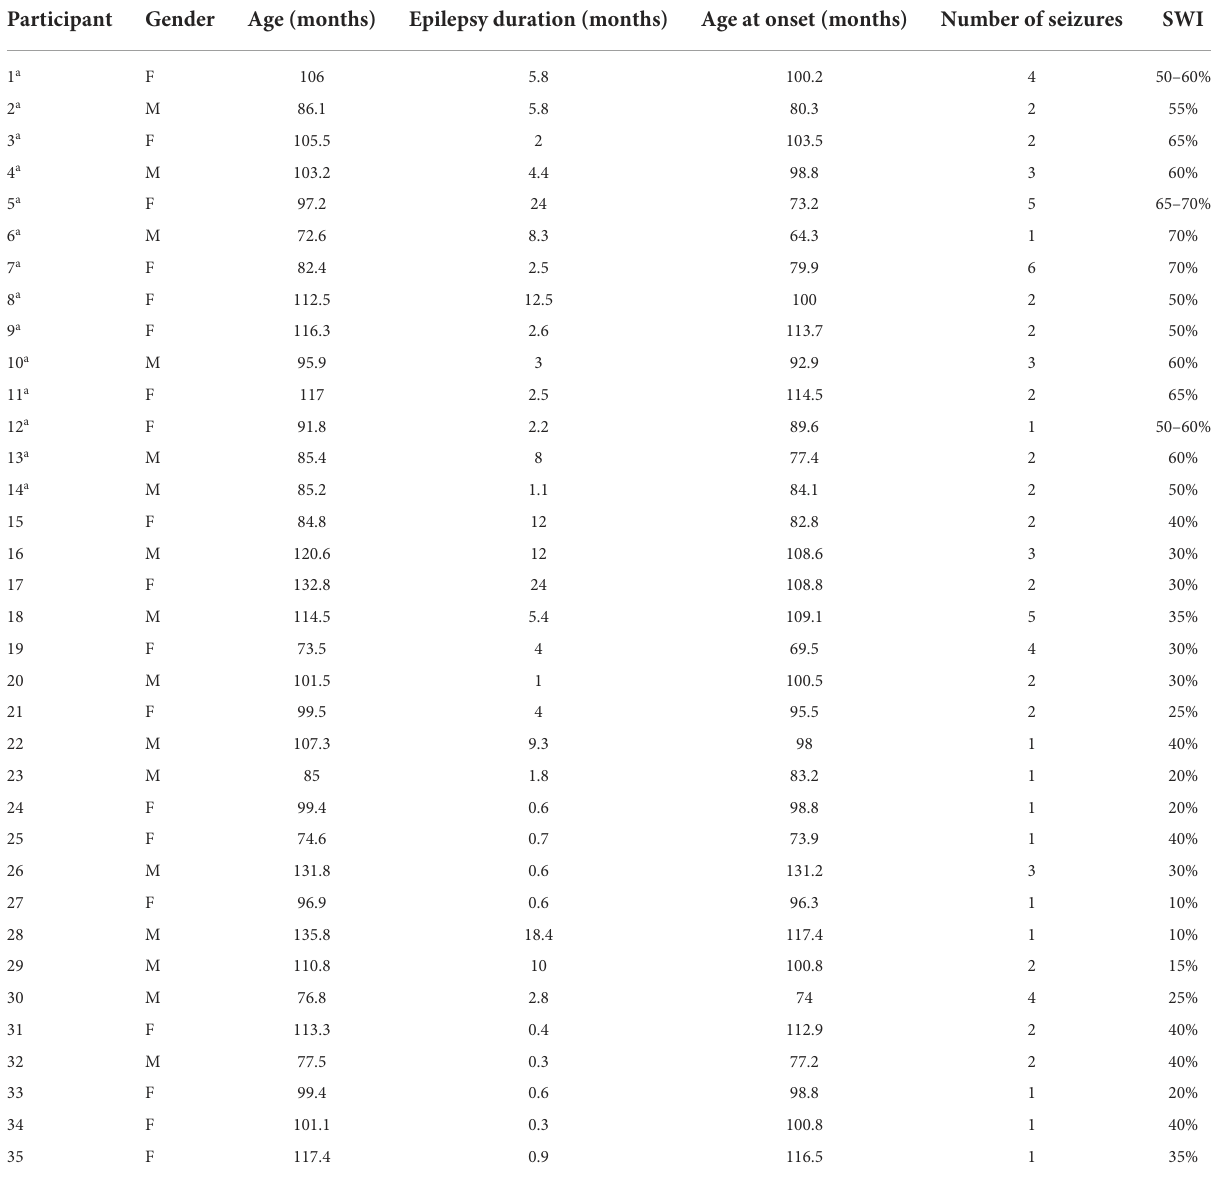
TABLE 1 Demographic and clinical characteristics of the included